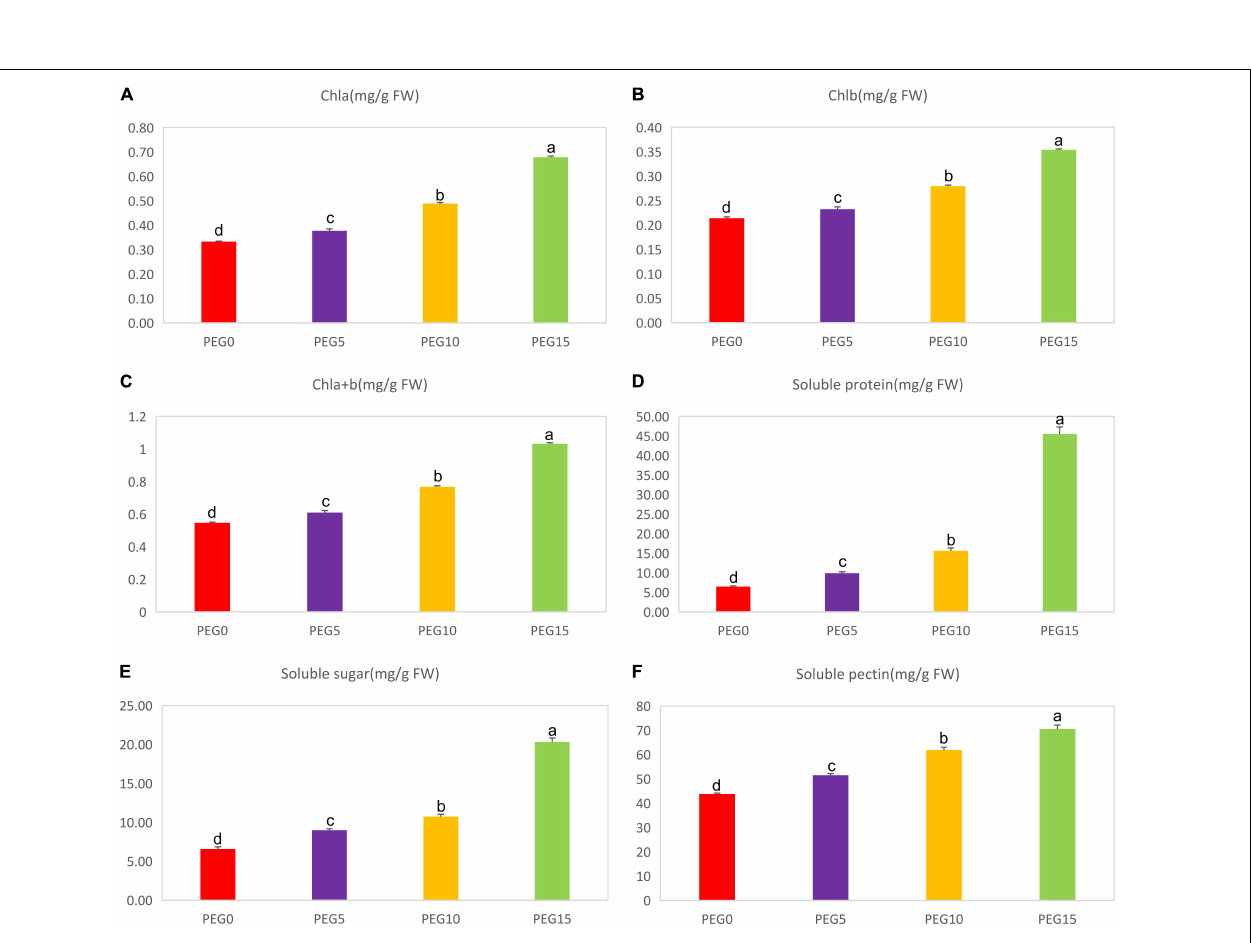
FIGURE 3 | Changes of the contents of Chla, Chlb, Chla + b, soluble protein, soluble sugar, and soluble pectin under different drought stress conditions. (A–F) The contents of Chla, Chlb, Chla + b, soluble protein, soluble sugar, and soluble pectin under different drought stress conditions, respectively. Different letters indicate the significant difference at the 0.05